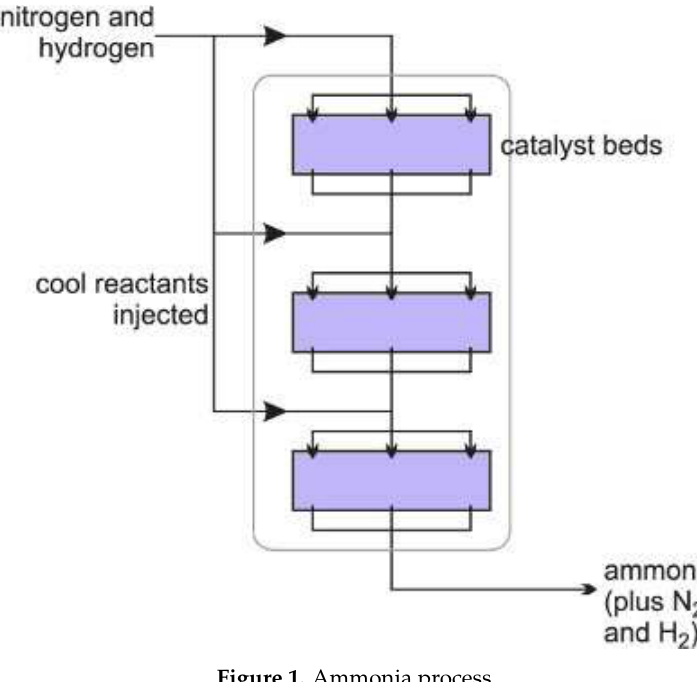
Figure 1. Ammonia